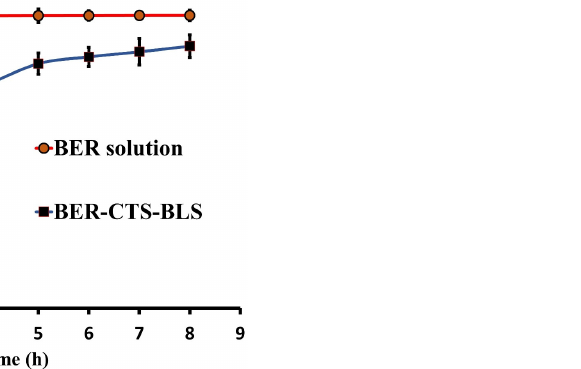
Figure 4. In vitro release profile of berberine from BER-CTS-BLS (optimal formula) and BER solu- tion.